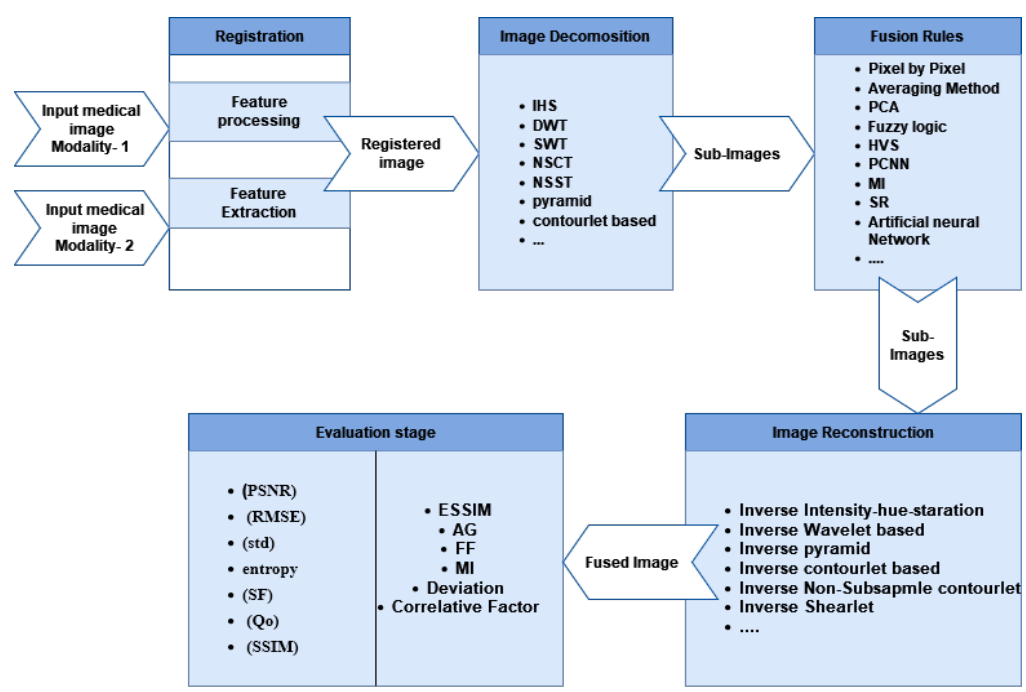
Figure 3. Medical image fusion step-by-step process.